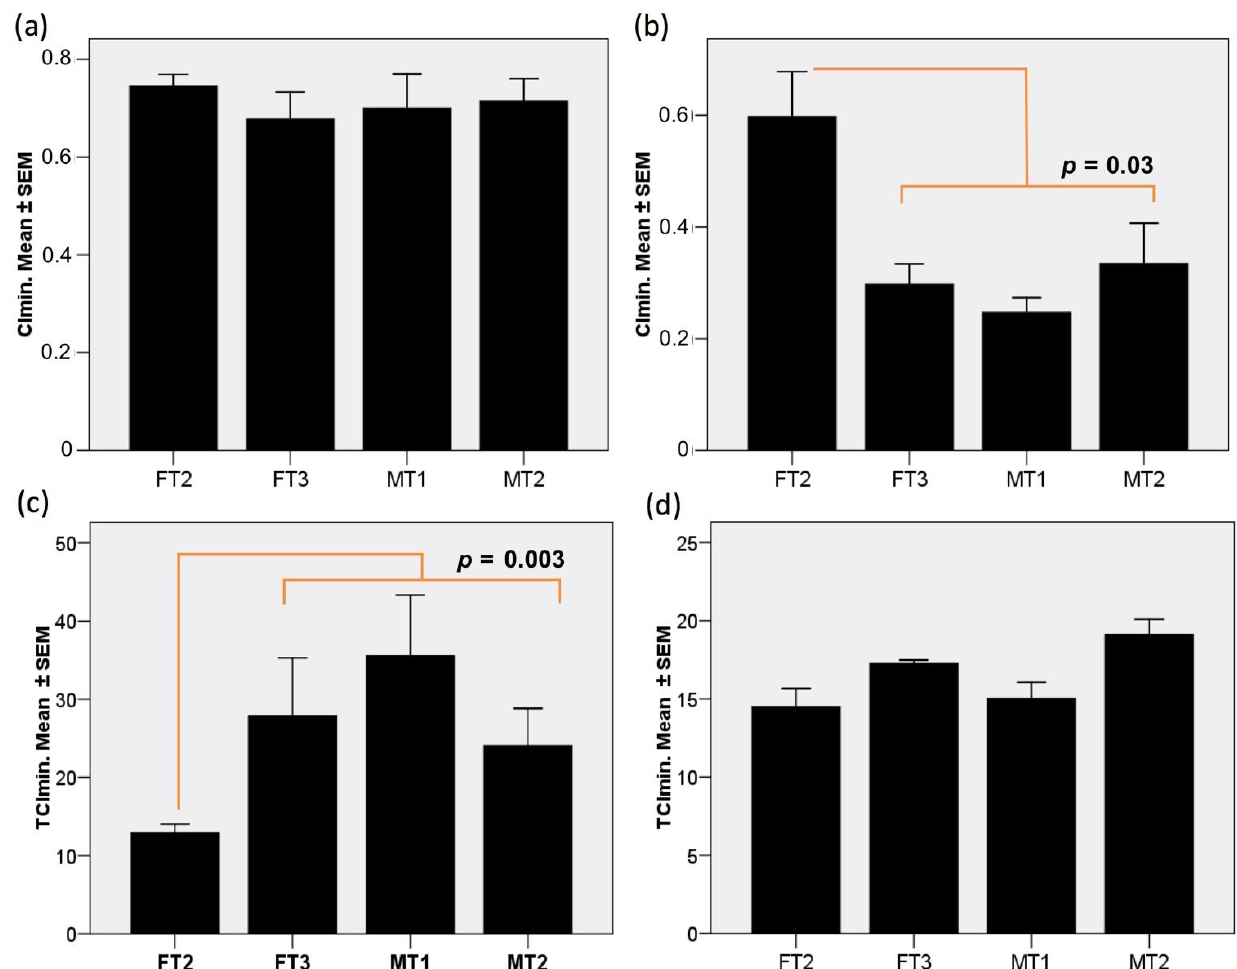
Figure 4. Fibroblast cultures expressing DAF show variable cytolysis responses to baboon and human serum challenge. Plots showing results of RTCA analysis: ( a ) CImin for the different transgenic fibroblasts lineages challenged without rabbit complement addition and ( b ) with rabbit complement addition. ( c ) TCImin observed for fibroblasts challenged without complement addition and ( d ) TCImin observed with rabbit complement addition. Results are shown as mean ± standard error of the mean (SEM) of triplicate measurements.